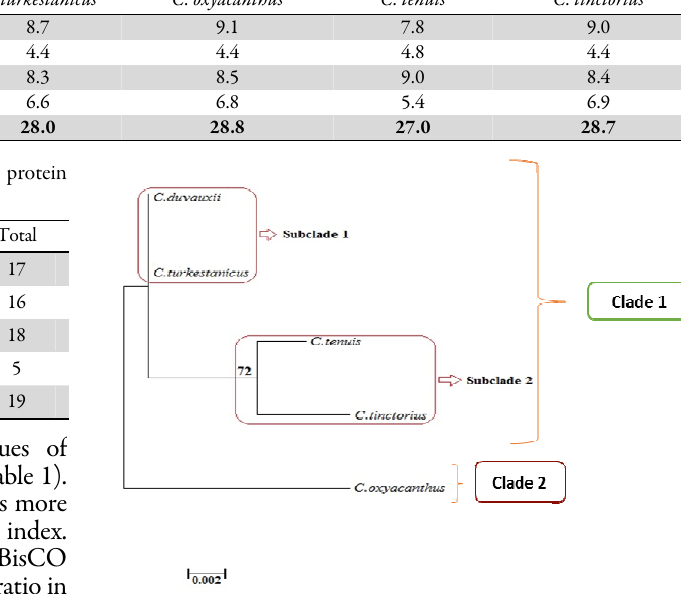
Fig. 3. Phylogenetic tree of Carthamus ssp. RuBisCO